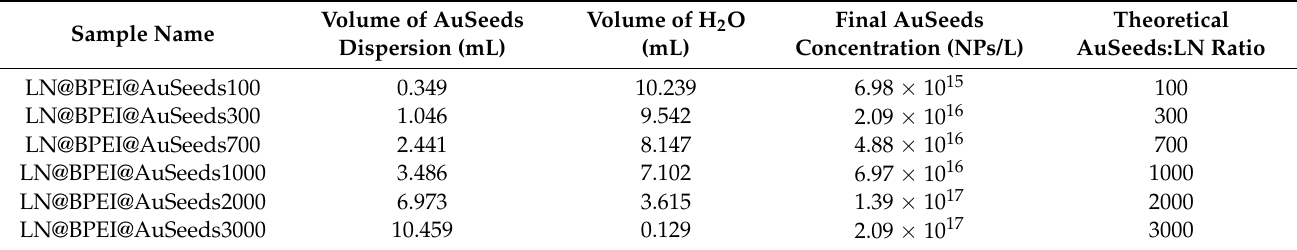
Table 1. Volumes and final concentrations of the AuSeeds dispersions used for varying the density of AuSeeds attached to the LN@BPEI surface. The stock AuSeeds dispersion had a concentration of 2.32 × 10 17 NPs/L. For each sample, 1 mL of 1.58 × 10 15 NPs/L of LN@BPEI was